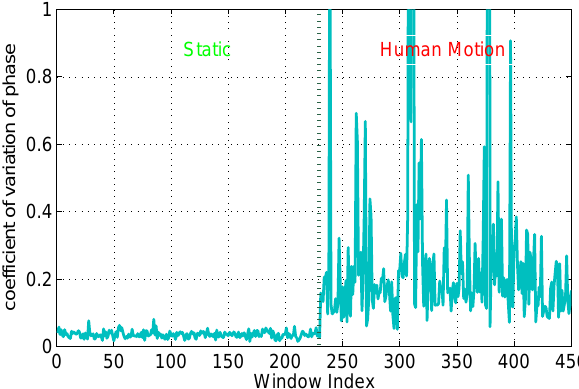
Figure 9. Coefficient of variation of phase in static/dynamic